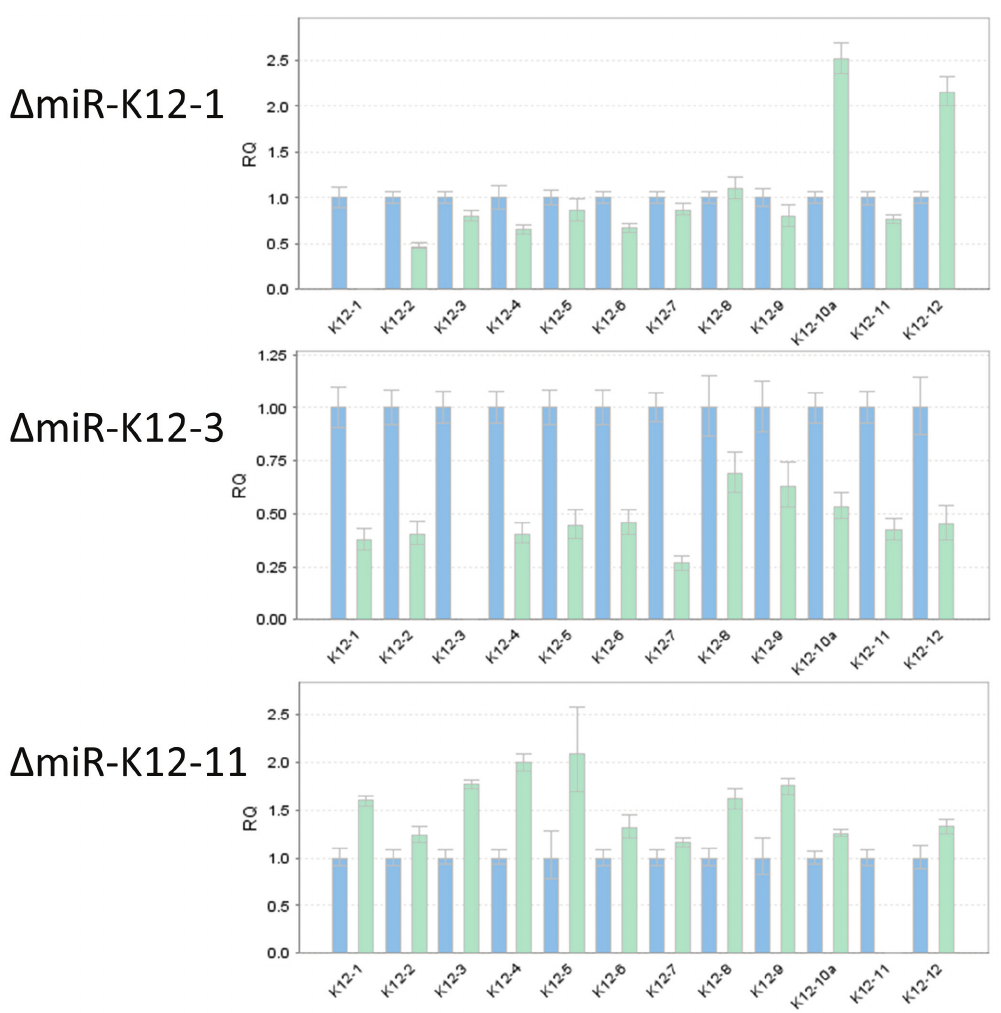
Figure 5. Confirmation of loss of miRNA expression in deletion mutants for miR-K12-1, miR-K12-3, and miR-K12-11. TaqMan miRNA assay was used to determine the levels of mature miRNAs K12-1 through K12-12 (strand-specificity for each Taqman miRNA assay is listed in Table S1). The blue bars show expression for wtKSHV normalized to 1. The cyan bars show expression levels for KSHV deleted for miR-K12-1 ( top ), miR-K12-3 ( center ), or miR-K12-11 ( bottom ).